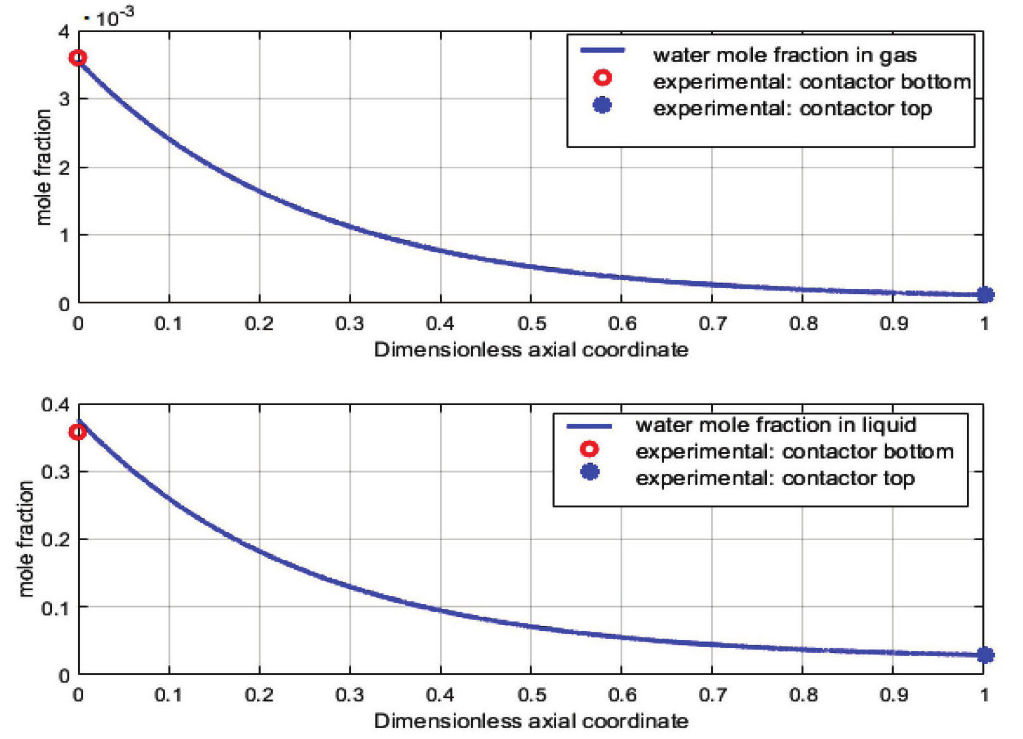
Fig. 6a – Example 1. Composition profiles (water mole fraction) of gas and liquid